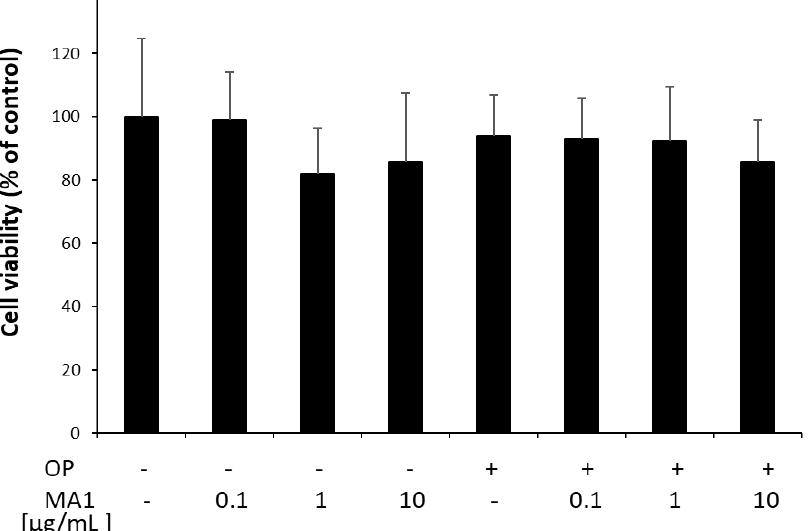
Figure 1. Viability of FaO cells treated for 24 h with 0.1, 1 and 10 µg/mL MA1, in the absence or in the presence of 0.75 mM OP. Data are expressed as percentage of control. Values are mean ± SD from three independent experiments.